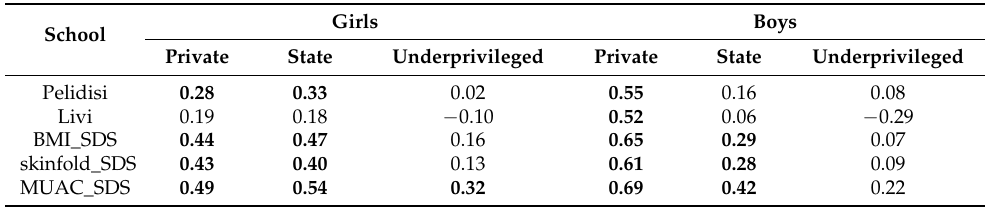
Table 3. Correlation coefficients between height SDS and measures of the nutritional state according to school type in Kupang (West-Timor). r < 0.01 are indicated by bold numbers. School